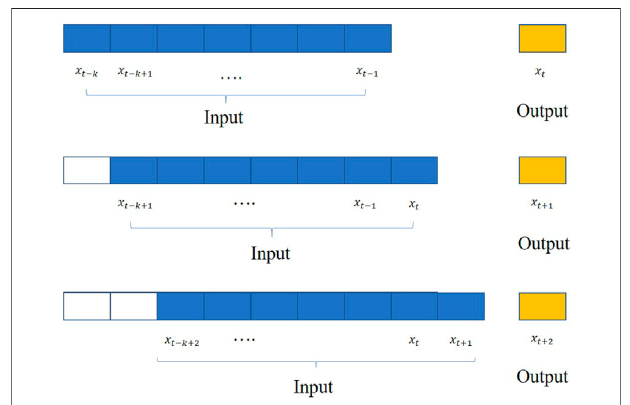
FIGURE 6 | Sequential prediction